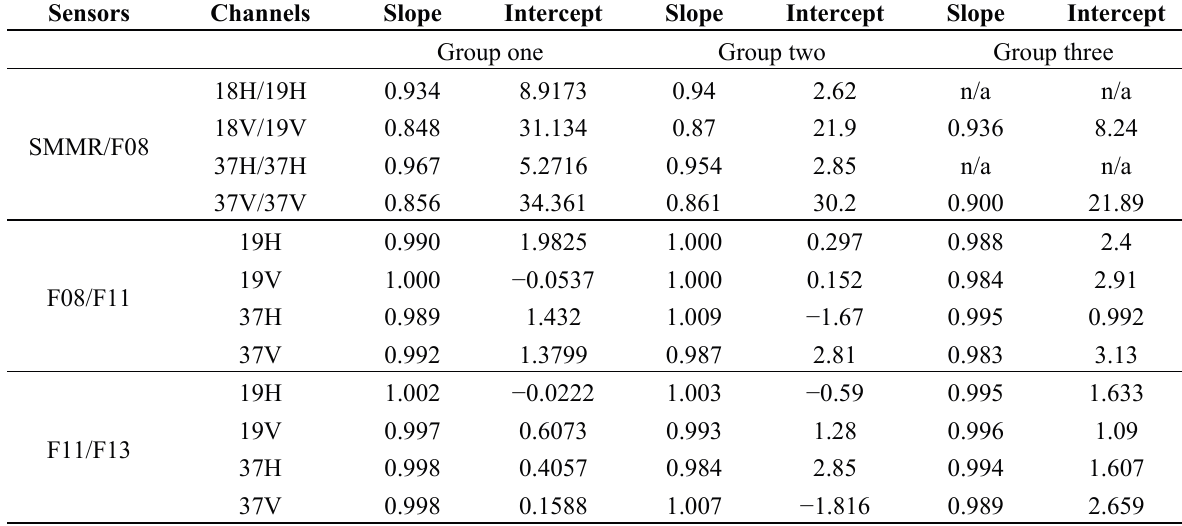
Table 4. Comparison of the calibration results from various studies. Group one is from Dai and Che [21]; group two is from Jezek et al. [20] for SMMR/F08, Abdalati et al. [22] for F08/F11, and Stroeve et al. [17] for F11/F13; and group three is from Derksen et al. [18] for SMMR/F08 and Stroeve et al. [17] for F11/